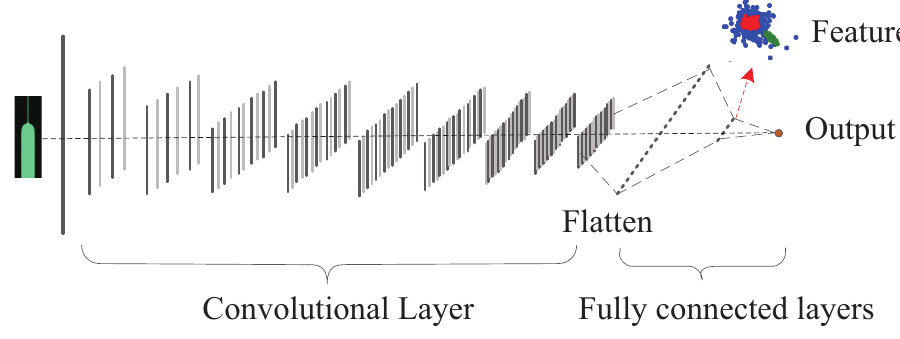
Figure 2. Framework of the discriminator D in the